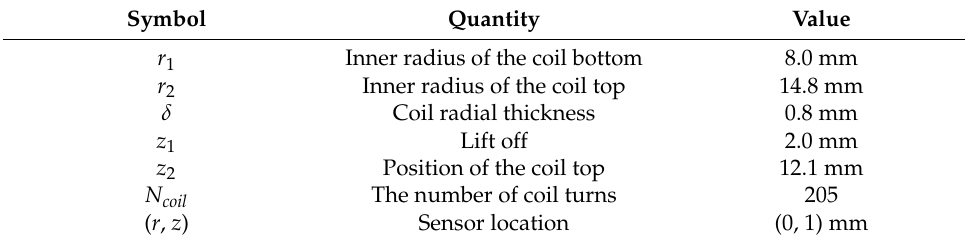
Table 1. Parameters of the PMEC probe.